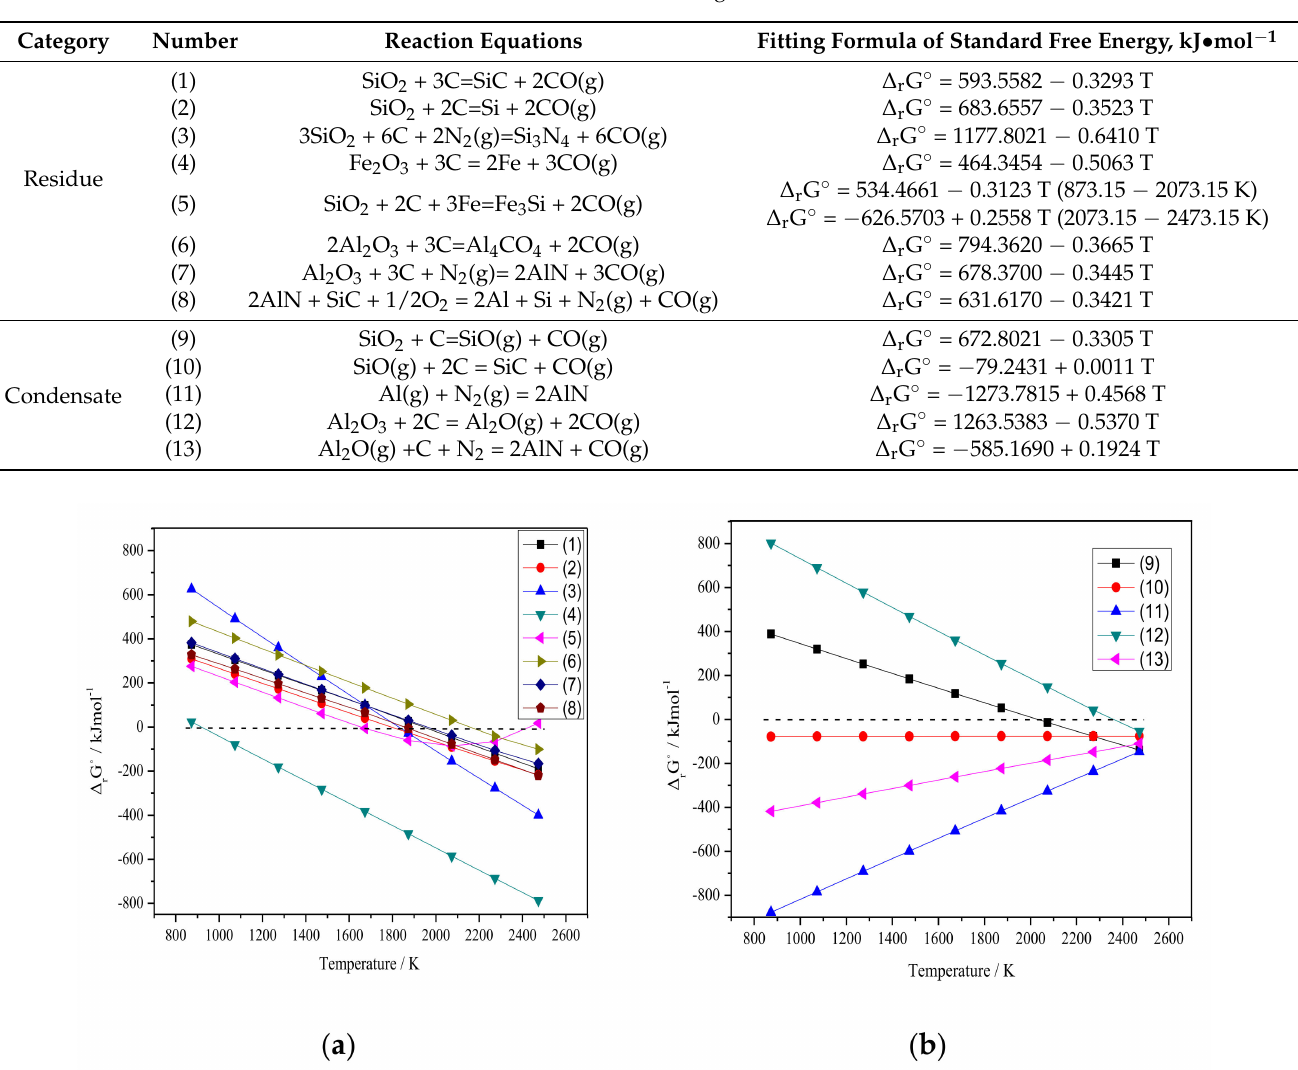
Table 3. Chemical reactions and fitting formula of ∆ r G θ − T.